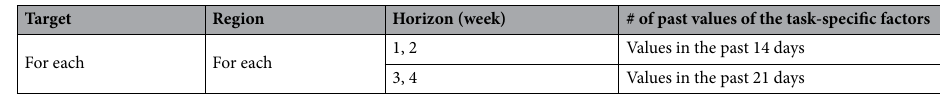
Table 4. The values of task-specific factors used as input for different forecasting